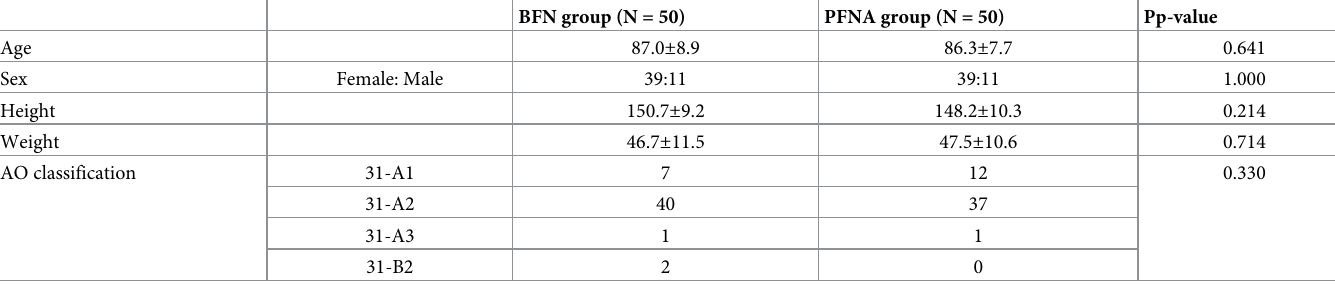
Table 1. Demographic characteristics of the patients in the BFN and PFNA